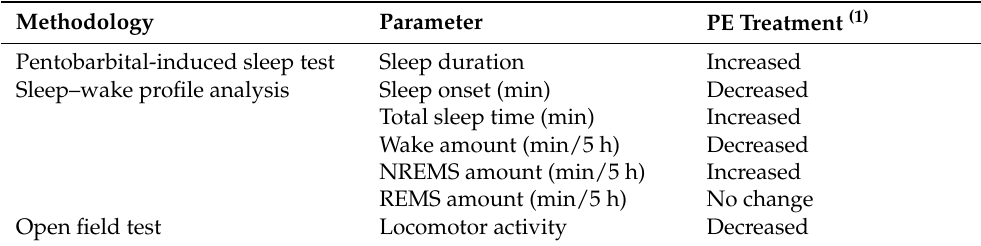
Table 1. Summary of the main findings in the present study.